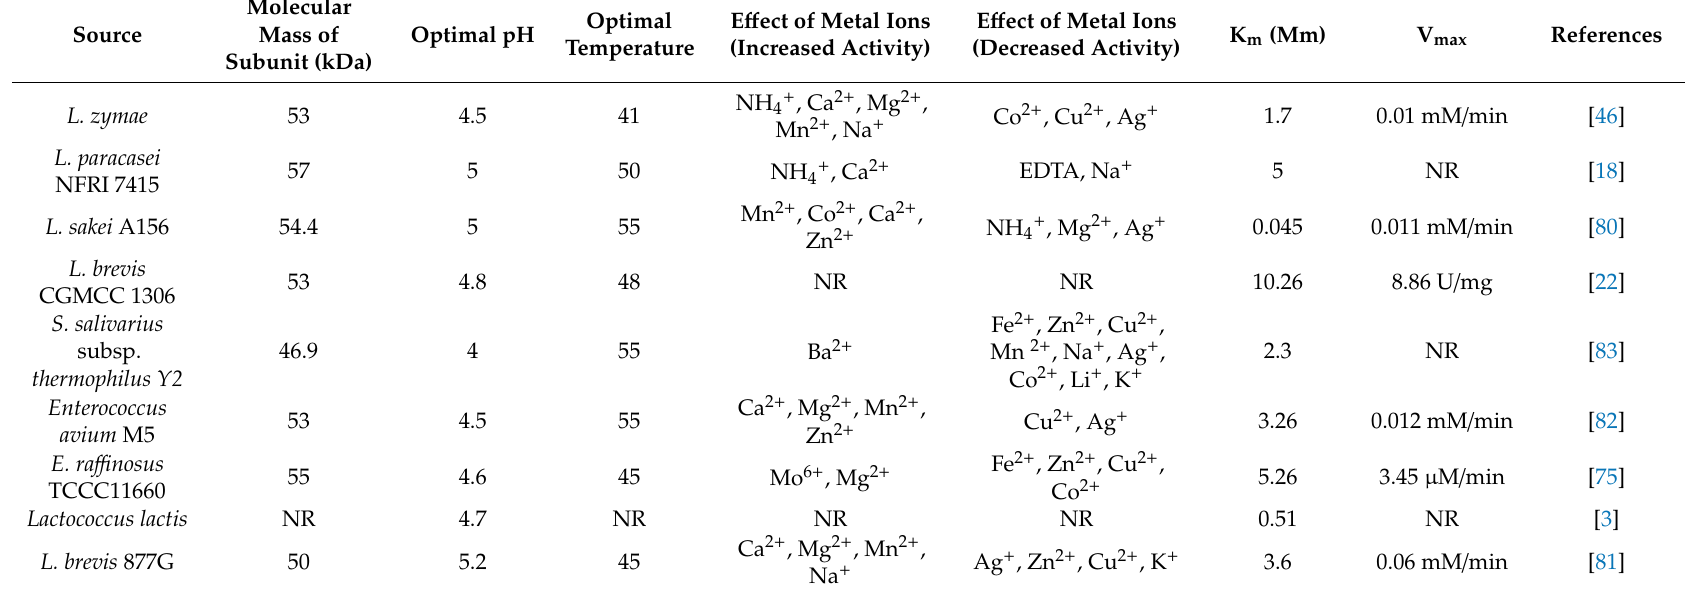
Table 2. Biochemical properties of glutamate decarboxylase from various